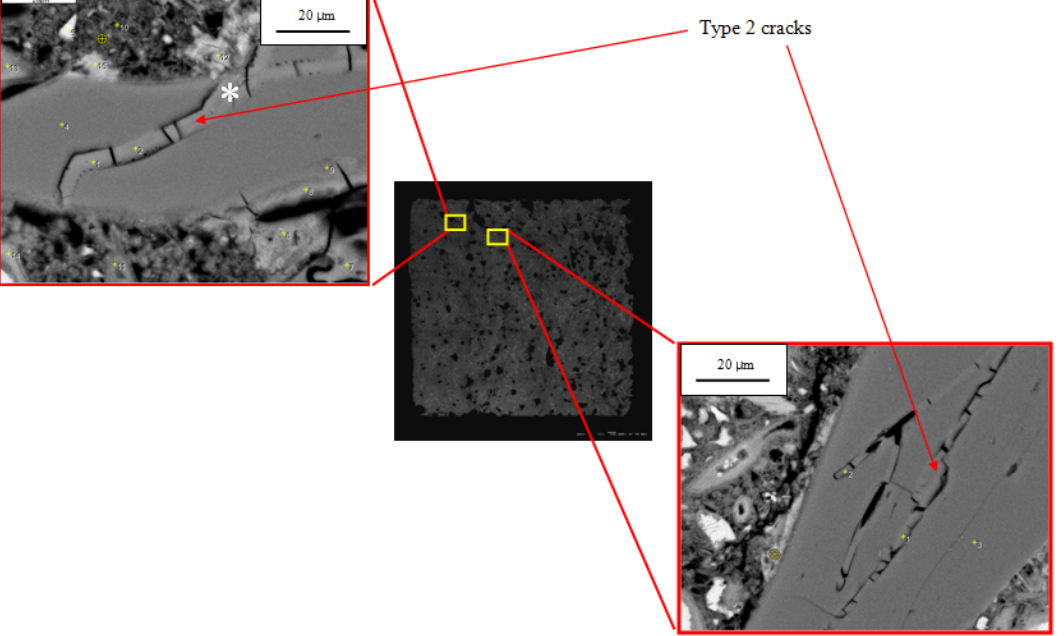
Figure 6. BSE images of ASR gel in aggregate grains in the 0-day specimen.